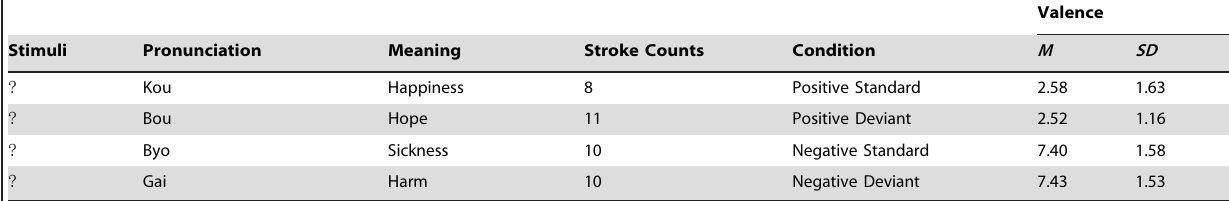
Table 2. Emotional word stimuli in Experiment 2.